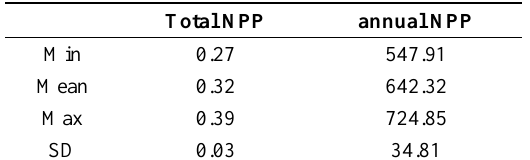
Table 3. Total NPP and annual NPP (1982-2015)